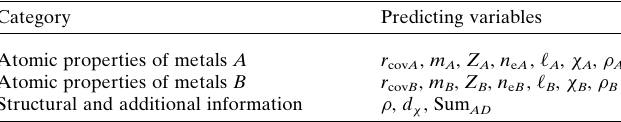
Table 3 The designed predicting variables describing the intrinsic properties of the constituent elements and the structural properties of the materials in the lattice parameter prediction problem. A and B are elements of the binary AB b.c.c. materials.